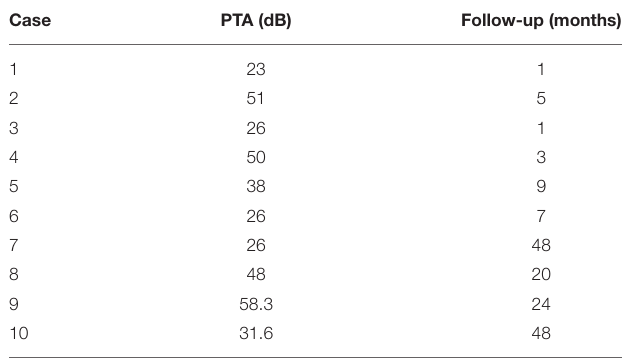
TABLE 2 | Demographics and symptomatology; *utricular, saccular EH was identified on repeat MRI 4 years following initial presentation with isolated cochlear